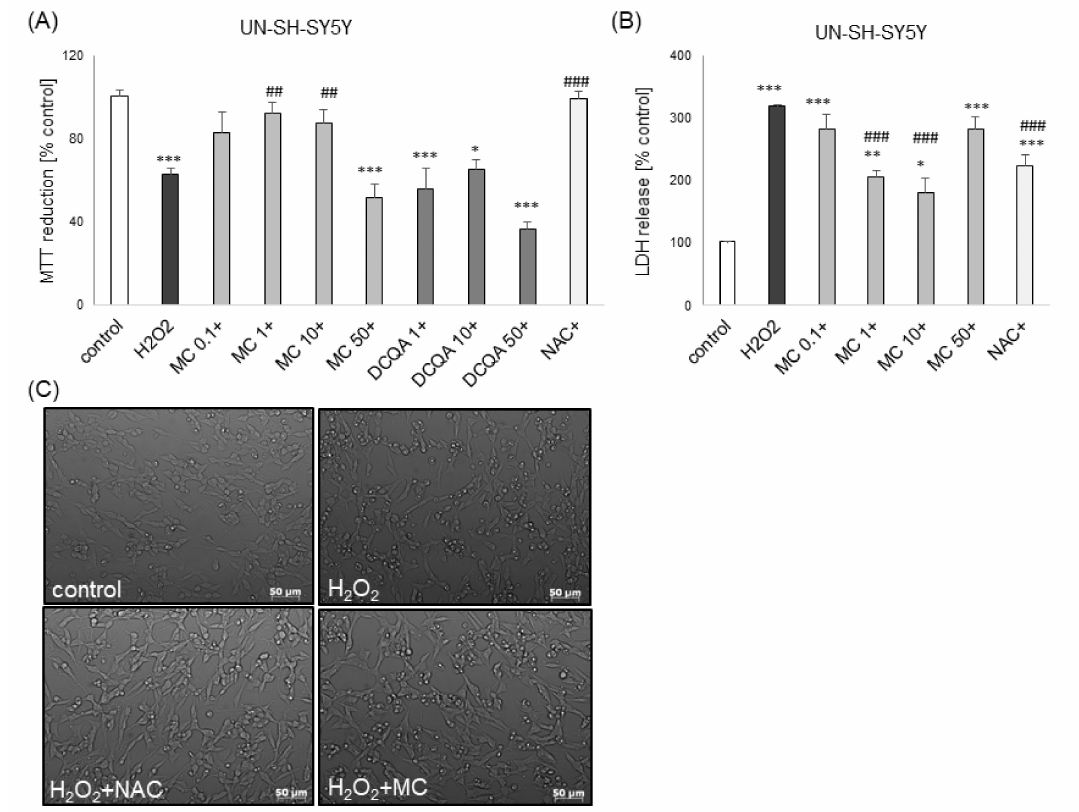
Figure 3. The protective e ff ects of methyl ca ff eate (MC) against hydrogen peroxide (H 2 O 2 )-evoked UN-SH-SY5Y cell damage. ( A , B ) Cell viability ( A ) and toxicity ( B ) in UN-SH-SY5Y cells pre-treated for 30 min. with MC (0.1-50 µ M) or 3,5-DCQA (1-50 µ M) or co-treated with N-acetylcysteine (NAC, 1 mM) followed by 24 of treatment with H 2 O 2 (0.25 mM) measured by MTT reduction and LDH release assays, respectively. Data were normalized to the vehicle-treated cells and are presented as the mean ± SEM. *** p < 0.001, ** p < 0.01 and * p < 0.05 vs. vehicle-treated cells; ### p < 0.001 and ## p < 0.01 vs. H 2 O 2 -treated cells. ( C ) Representative DIC (di ff erential interference contrast) images of UN-SH-SY5Y cells treated for 24 h with MC (10 µ M) or N-acetylcysteine (1 mM) and H 2 O 2 (0.25